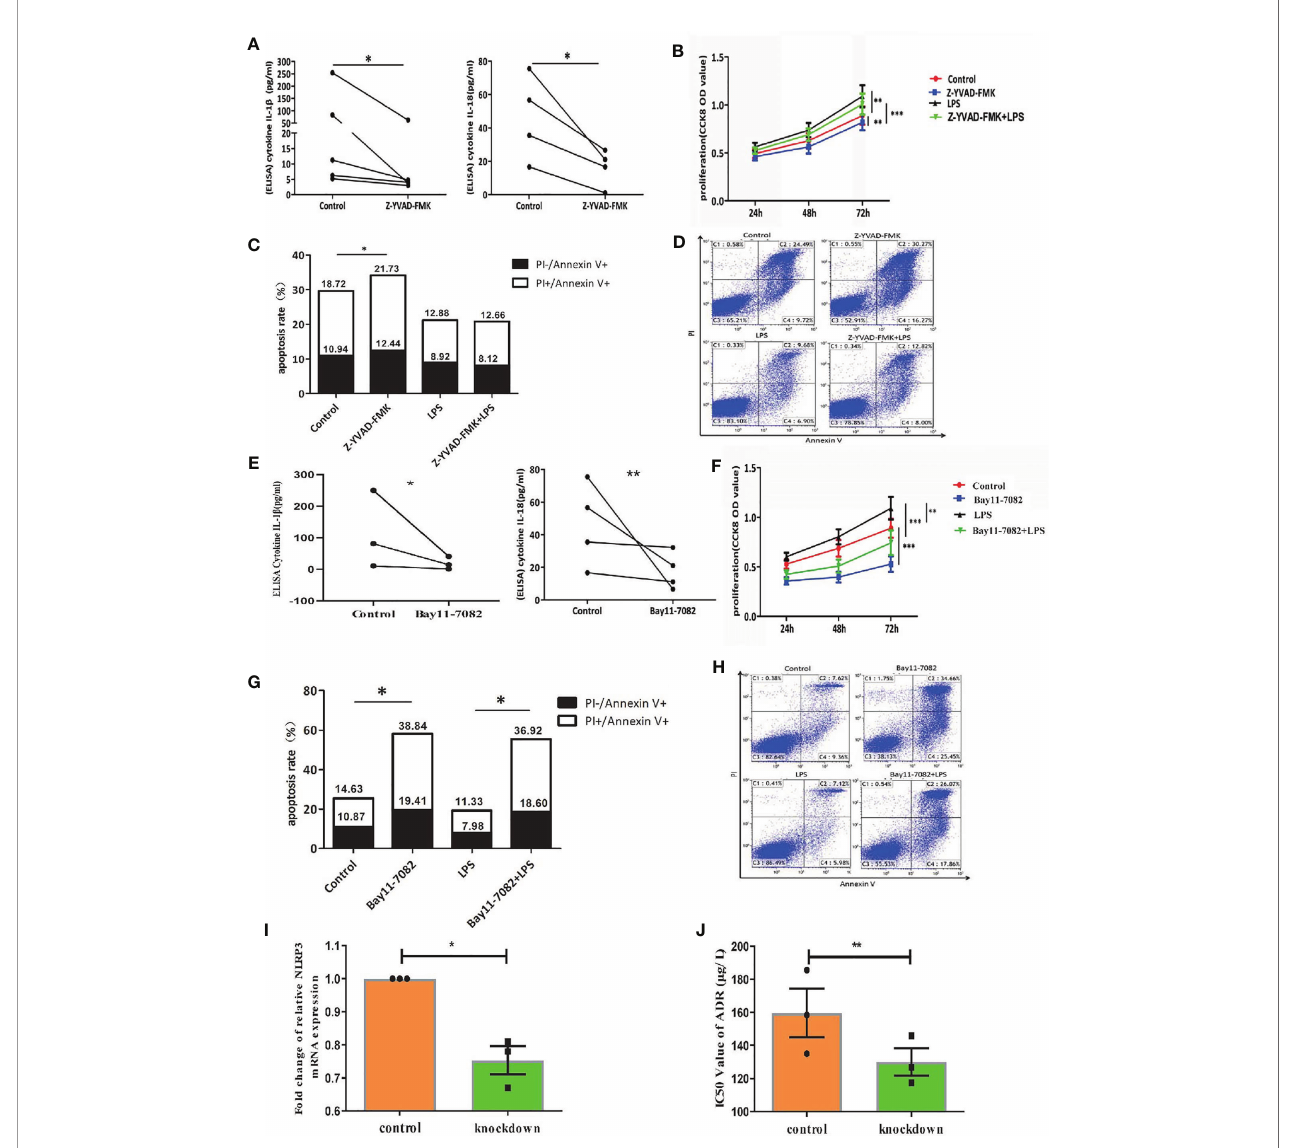
FIGURE 3 | Inactivation of NLRP3 in fl ammasome by caspase-1 or NF- k B inhibitor suppresses AML leukemia cells in vitro . (A) The concentration of IL-1 b (n=5) and IL-18 (n=4) in supernatants of cultured leukemia cells following Z-YVAD-FMK treatment. (B) Cell proliferation was analyzed by CCK8 assay in primary leukemia cells 24, 48 and 72 hours after treatment with LPS or/and Z-YVAD-FMK (n=8). (C) The apoptosis rate of leukemia cells in primary leukemia cells 48 hours after treatment with LPS or/and Z-YVAD-FMK (n=5). (D) Representative scatter plots of apoptosis. (E) ELISA results of secreted IL-1 b (n=3) and IL-18 (n=4) by AML primary leukemia cells after treatment with Bay11-7082. (F) Cell proliferation was analyzed by CCK8 assay in primary leukemia cells 24, 48 and 72 hours after treatment with LPS or/and Bay11-7082 (n=7). (G) The apoptosis rate of leukemia cells in primary leukemia cells 48 hours after treatment with LPS or/and Bay11-7082 (n=3). (H) Representative scatter plots of apoptosis. (I) The results of NLRP3 mRNA expression in THP1 cells after being transfected with lentivirus (n=3). (J) The IC50 values of ADR for THP1 cells after downregulating NLRP3 expression (n=3). *P < 0.05; **P < 0.01; ***P <